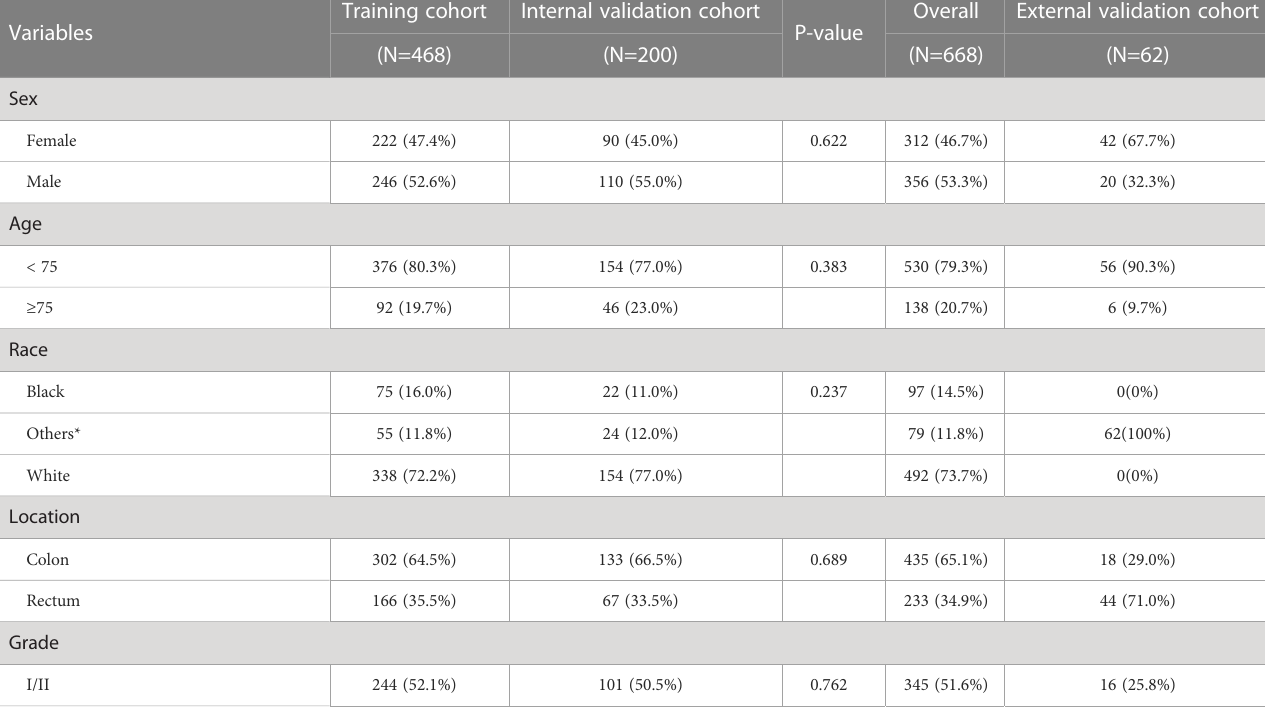
TABLE 1 Clinicopathological characteristics of patients with stage II-IV CRNENs.